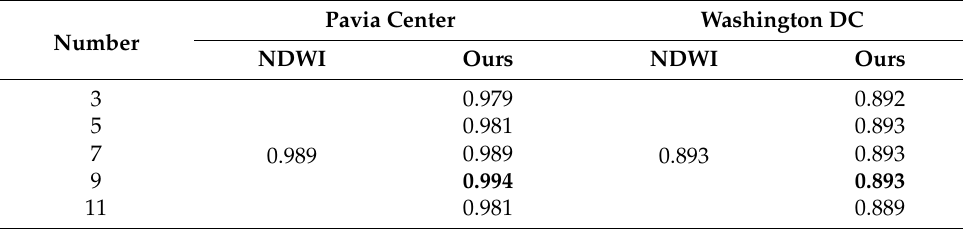
Table 15. The overall accuracy of water body extraction for the different number of bands. Number